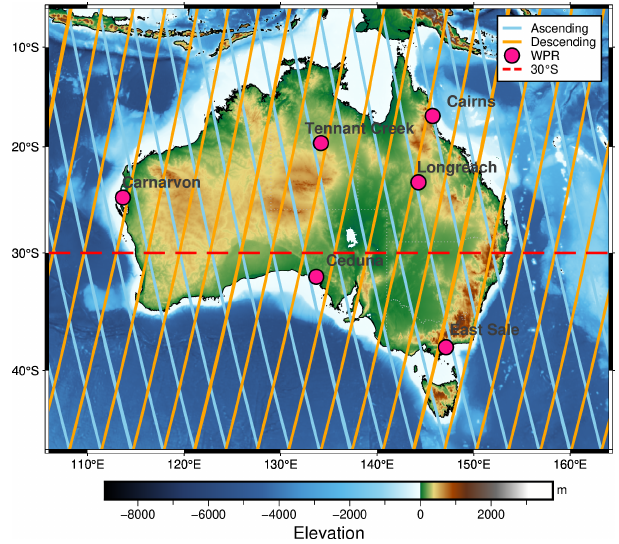
Figure 1. Location of wind profiling radars and Aeolus ground tracks over Australia. The pink marks on the map represent the sites of WPR used in this study, and the blue and orange lines indicate the Aeolus ground tracks for ascending and descending orbits, re- spectively. The red dashed line at 30 ◦ S is the boundary between the tropics and extratropics. Shading with different colours represents the earth relief. The elevation data were accessed and the map was created by the authors using PyGMT (Wessel et al., 2019; Tozer et al., 2019; Uieda et al.,